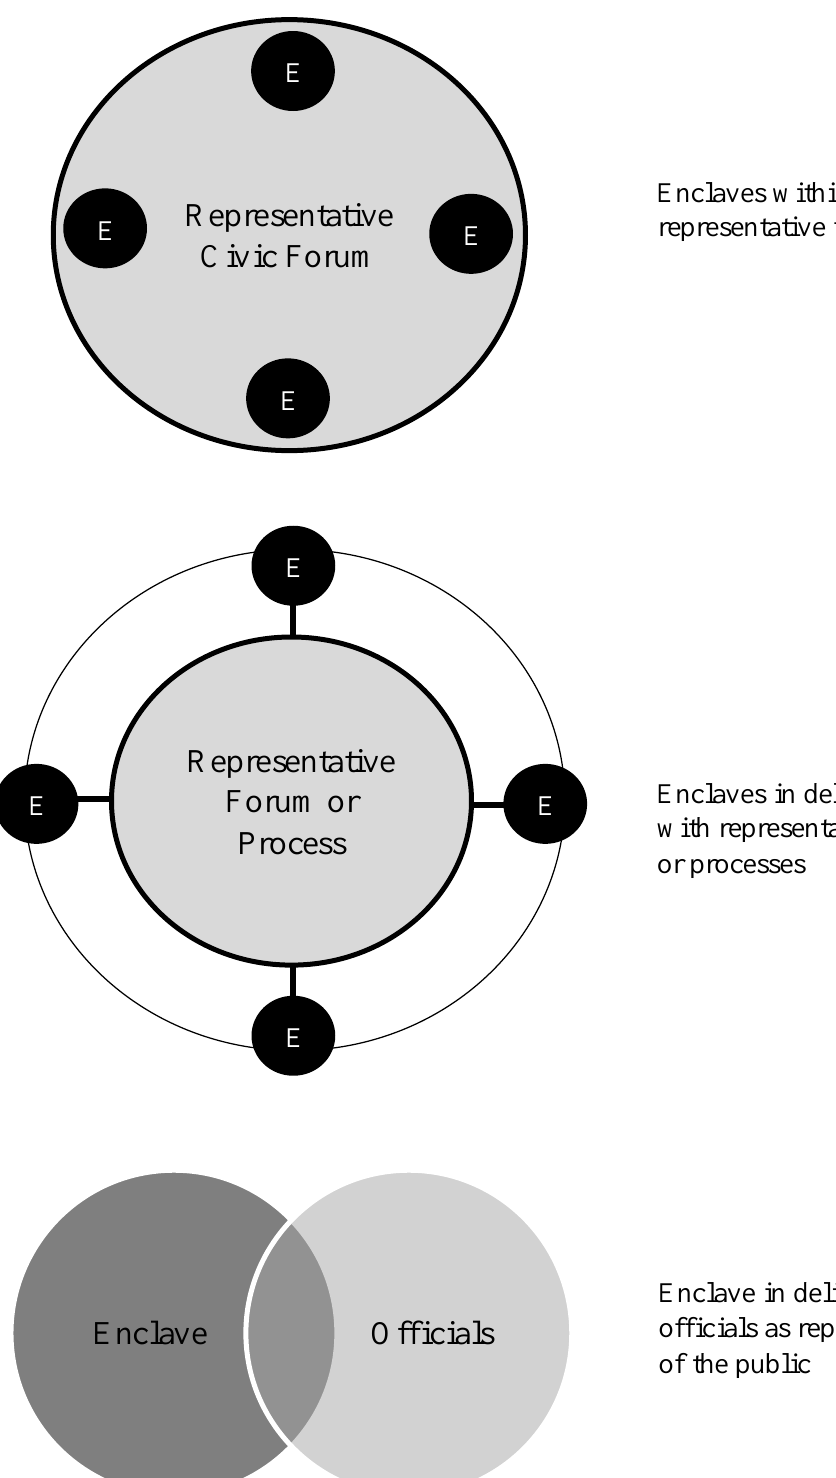
Figure 1. Some Ways of Integrating Enclave